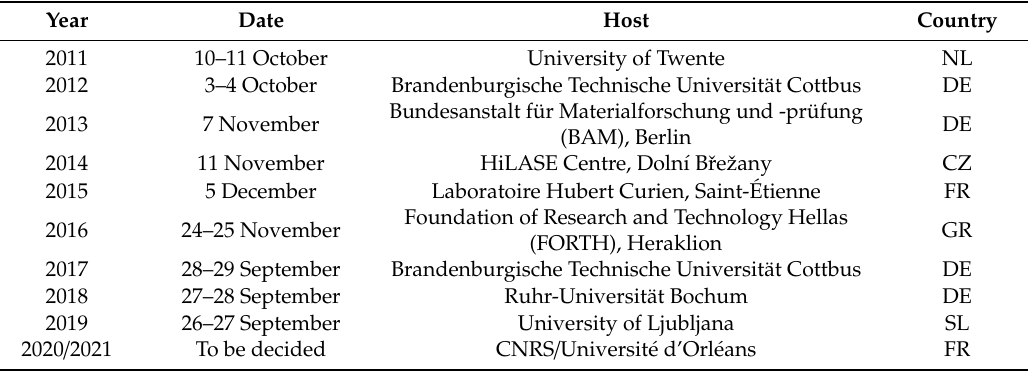
Table 4. History of the International Workshop on Laser-Induced Periodic Surface Structures